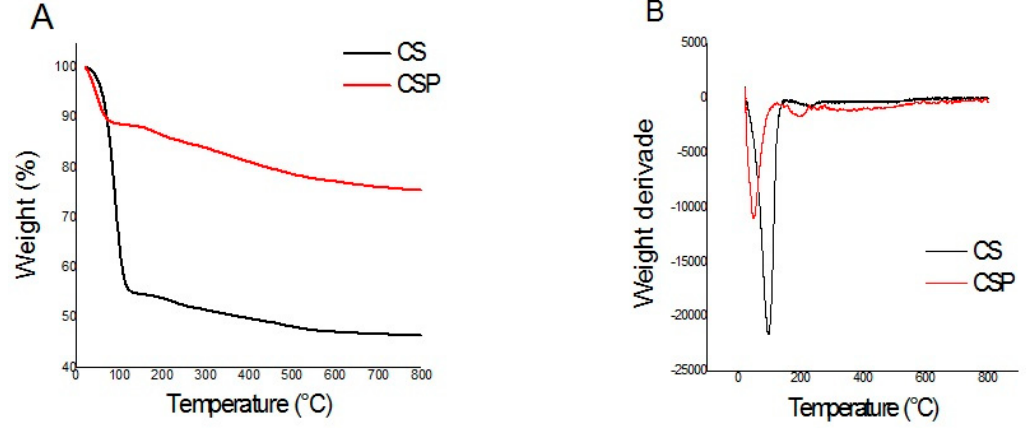
Figure 2. Thermogravimetric curves thermogravimetric analysis (TG) ( A ) and first derivative (DTG) ( B ) of adsorbent CS and CSP materials.